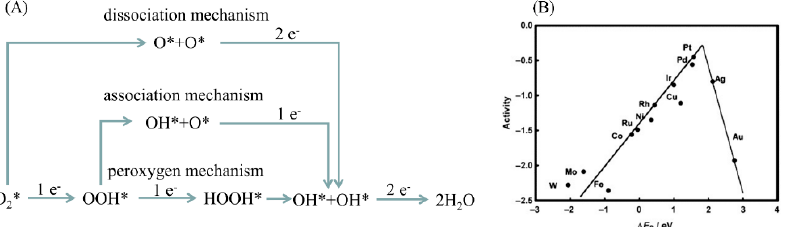
Figure 6. ( A ) Proposed oxygen reduction reaction (ORR) mechanisms. Reproduced with permission from [80] Copyright © 2021 WILEY-VCH. ( B ) Volcano-type relationship for the ORR activity versus the oxygen-binding energy. Reproduced with permission from [81] Copyright © 2021 The American Chemical Society.